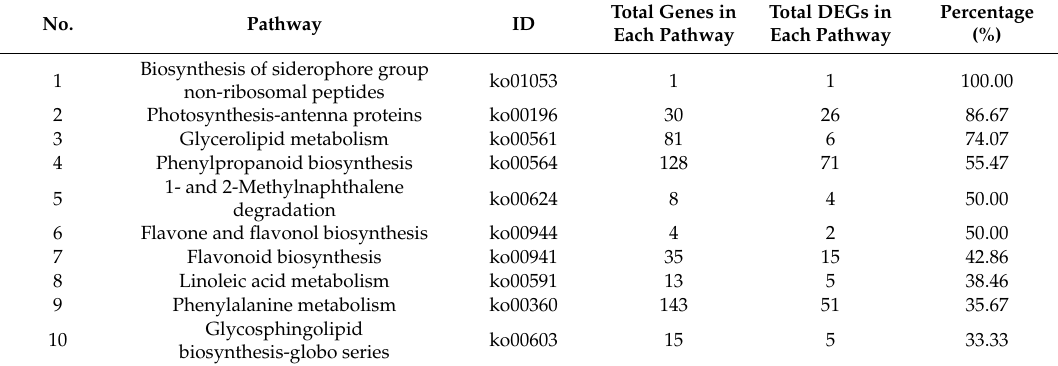
Table 4. Significant enrichment of the top 10 P. edulis ‘Pachyloen’-specific gene metabolic pathways.